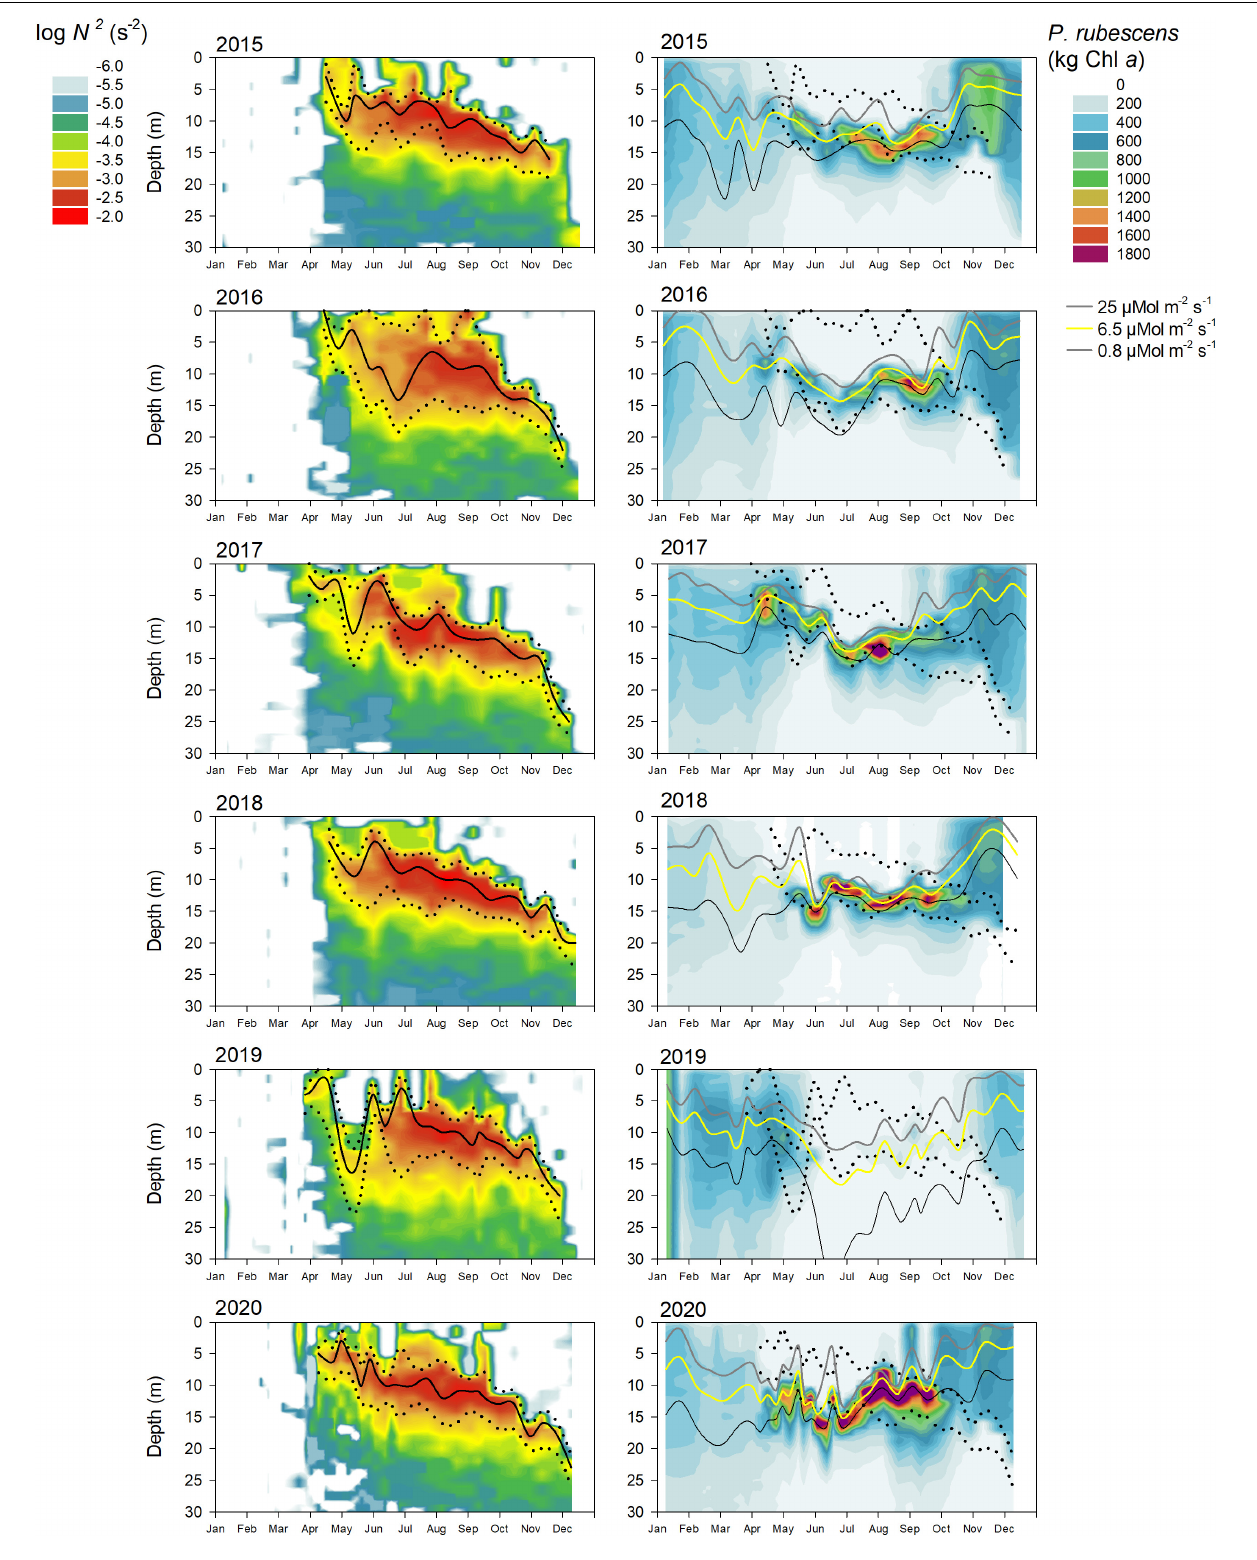
FIGURE 6 | Relationship between water column stability N 2 , light intensity, and the cumulative P. rubescens biomass for the upper 30 m water column from 2015 to 2020 in Lake Zurich. See legend of Figure 5 for further details.